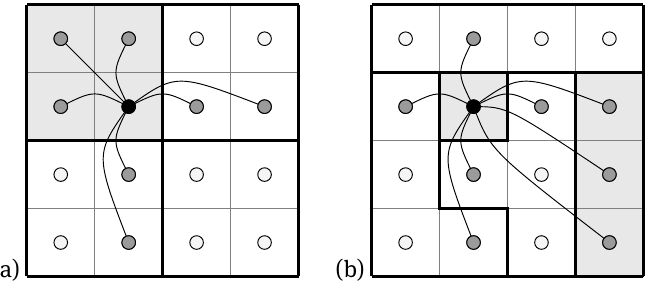
Figure 1: Deriving the graph of a classic and a free-form 2 -Sudoku